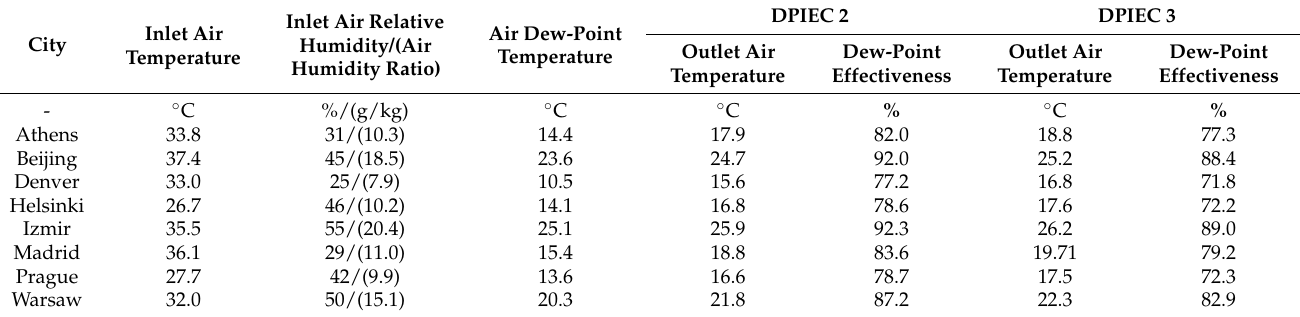
Table 5. Performance of the dew-point indirect evaporative coolers analyzed for the selected